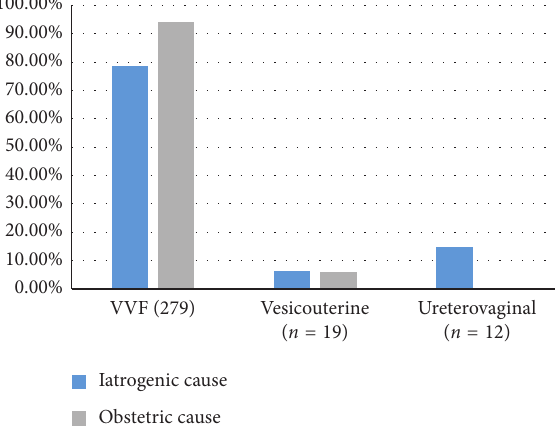
Figure 2: Type of